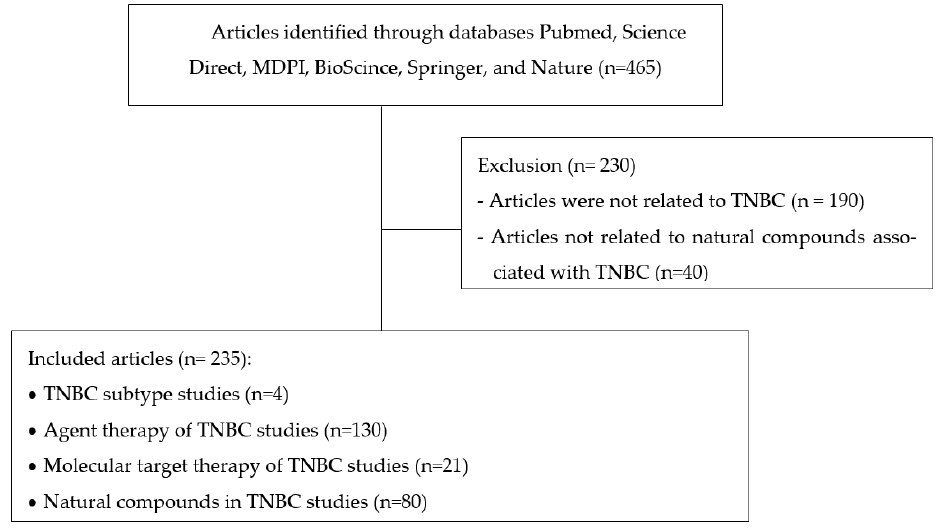
Figure 1. Article literature search flow chart.